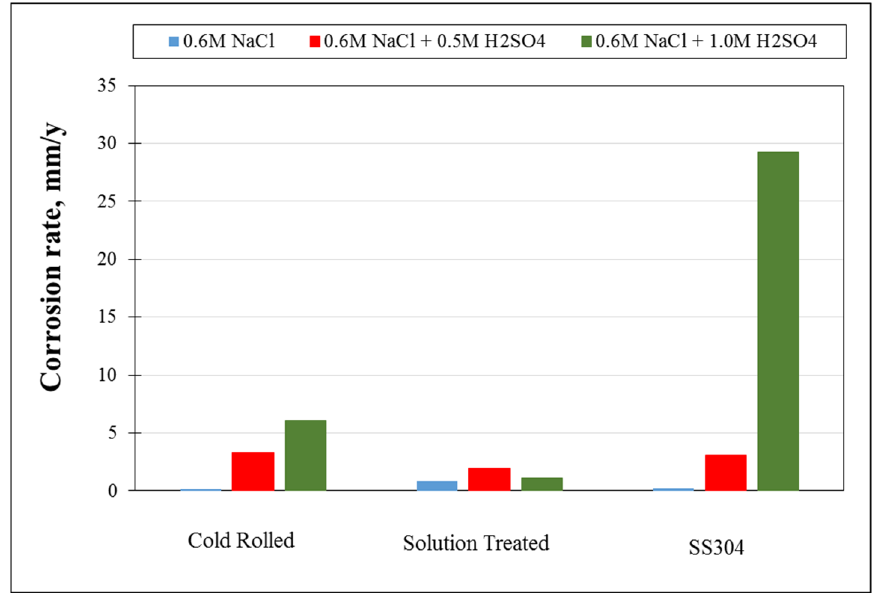
Figure 20. Comparison between the corrosion rates of cold-rolled and solution-treated Fe 36 Mn 20 Ni 20 Cr 16 Al 5 Si 3 HEA, and SS304 in different corrosion medium conditions.